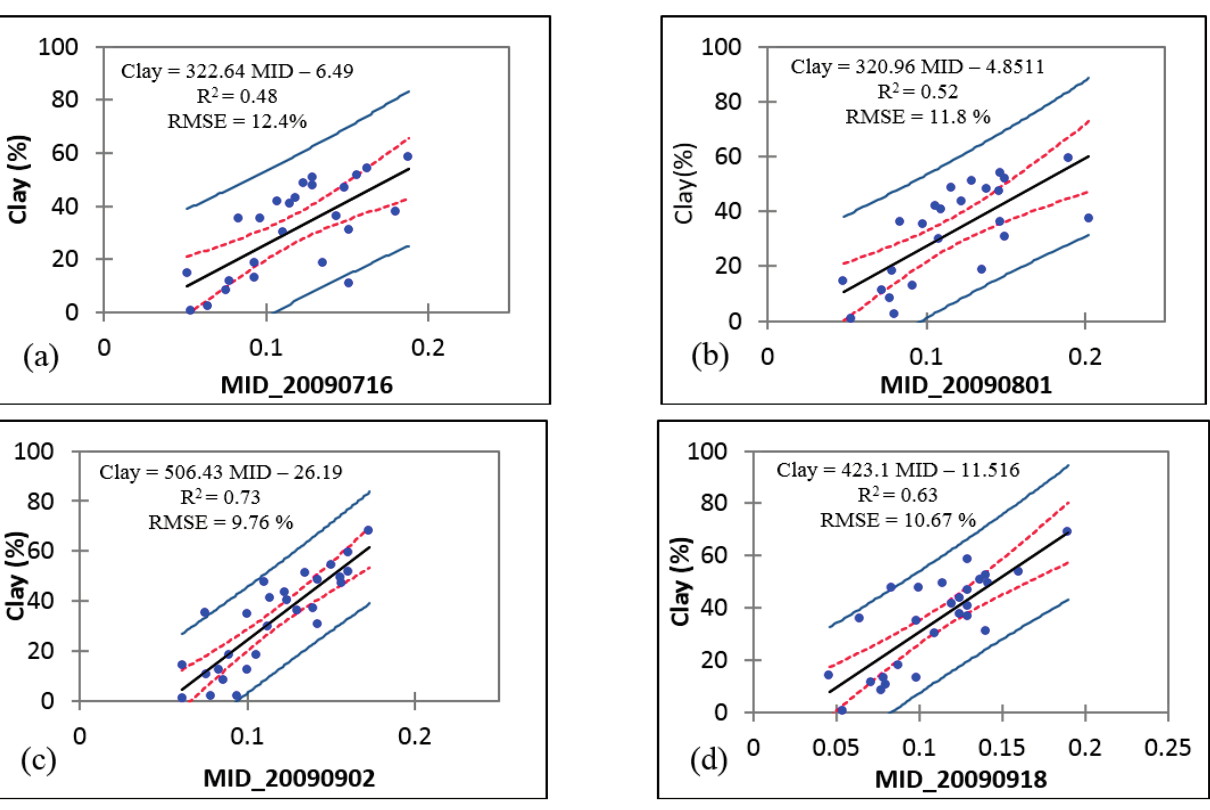
Figure 4. Linear relationship between MID-infrared index and observed clay content: ( a ) 16 July 2009; ( b ) 1 August 2009; ( c ) 2 September 2009; and ( d ) 18 September 2009. (Blue dots) observed clay content values. The red dotted line is the confidence interval of the mean. The blue line is the confidence interval for clay content observation. The continuous black line is the y-axis data versus x-axis data regression